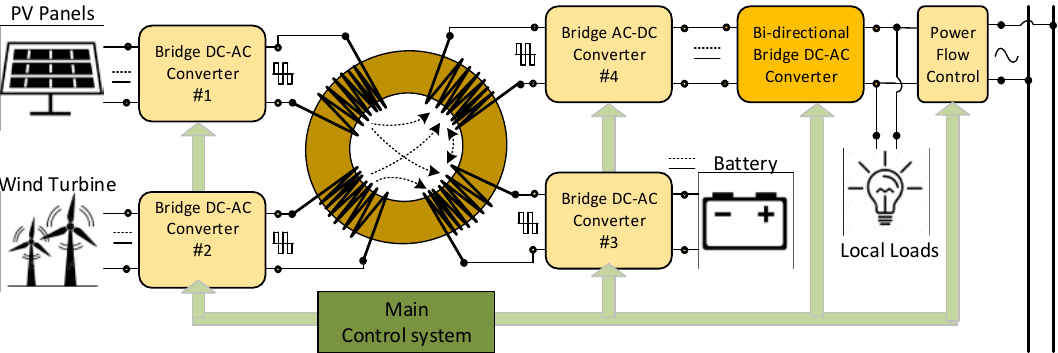
Figure 1. Topology of the proposed hybrid renewable energy system, including the multi-port phase shift converter and grid-connected inverter.